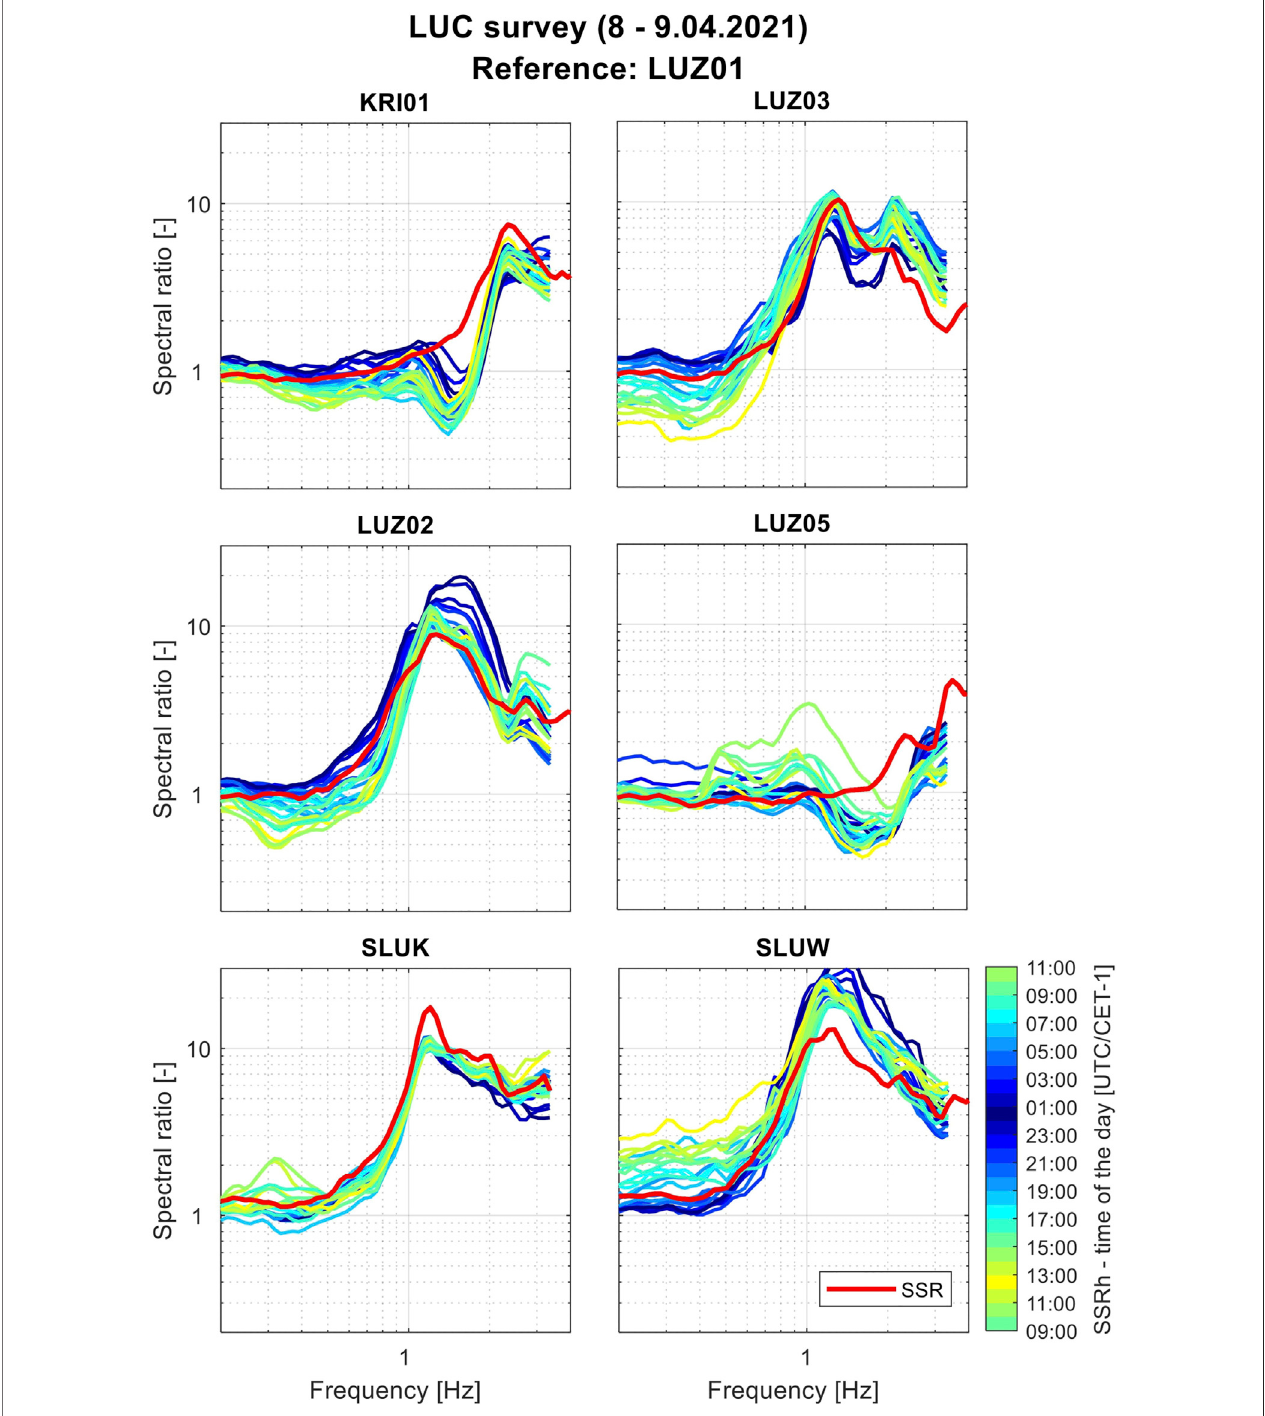
FIGURE 13 | Variability of the SSRh results between all stations that recorded for at least 24 h in the period 8-9.04.2021.